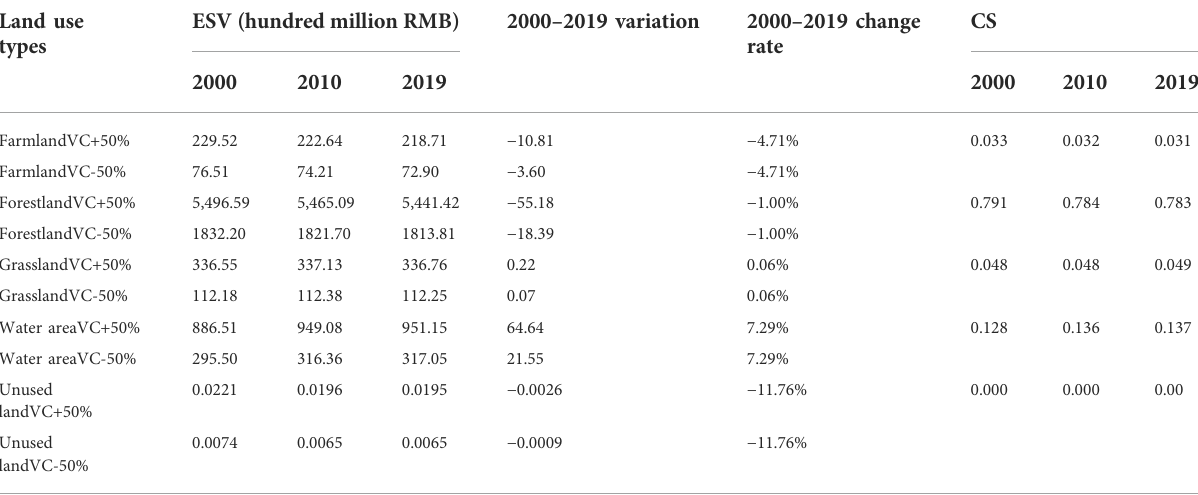
TABLE 3 Sensitivity index of ESs value in YRDEB from 2000 to